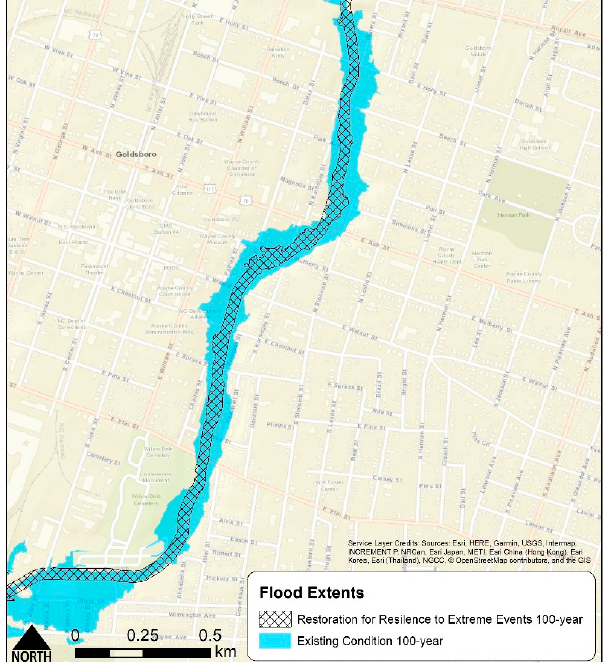
Figure 12. Flood inundation extents for the Existing Condition and the Restoration for Resilience to Extreme Events scenario for the 100-year event in downtown Goldsboro,